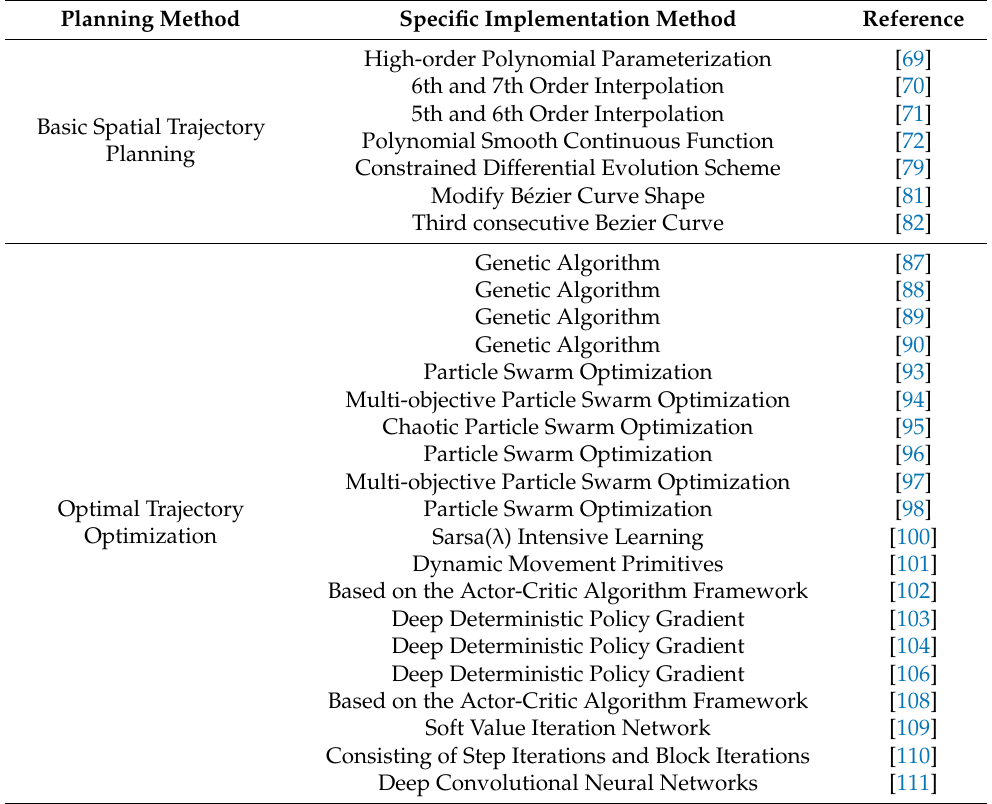
Table 3. Spatial robotic arm motion trajectory planning study summary